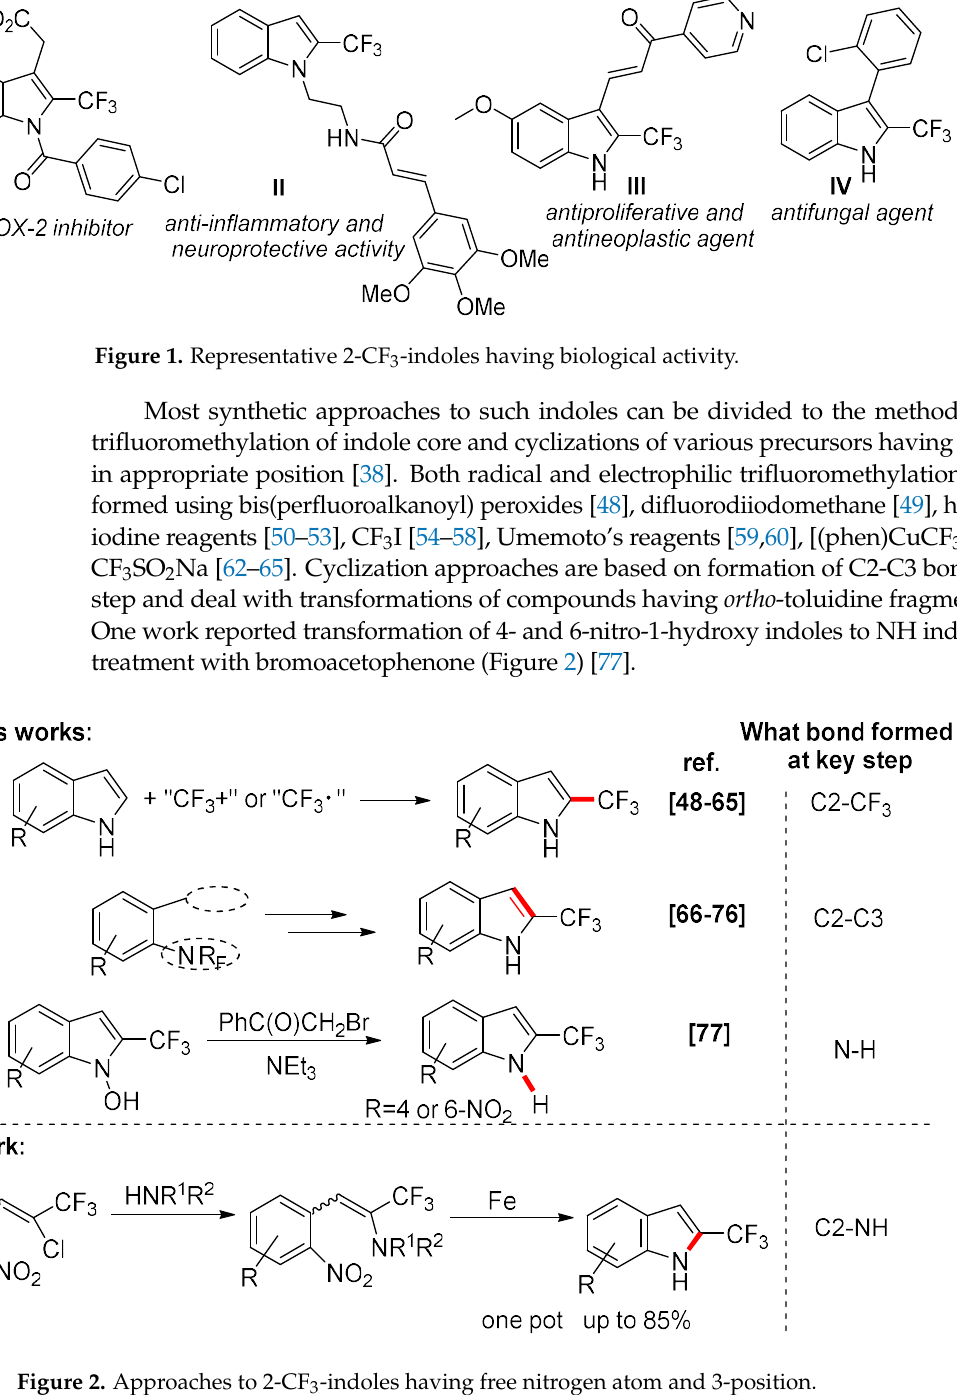
Figure 1. Representative 2-CF 3 -indoles having biological activity.